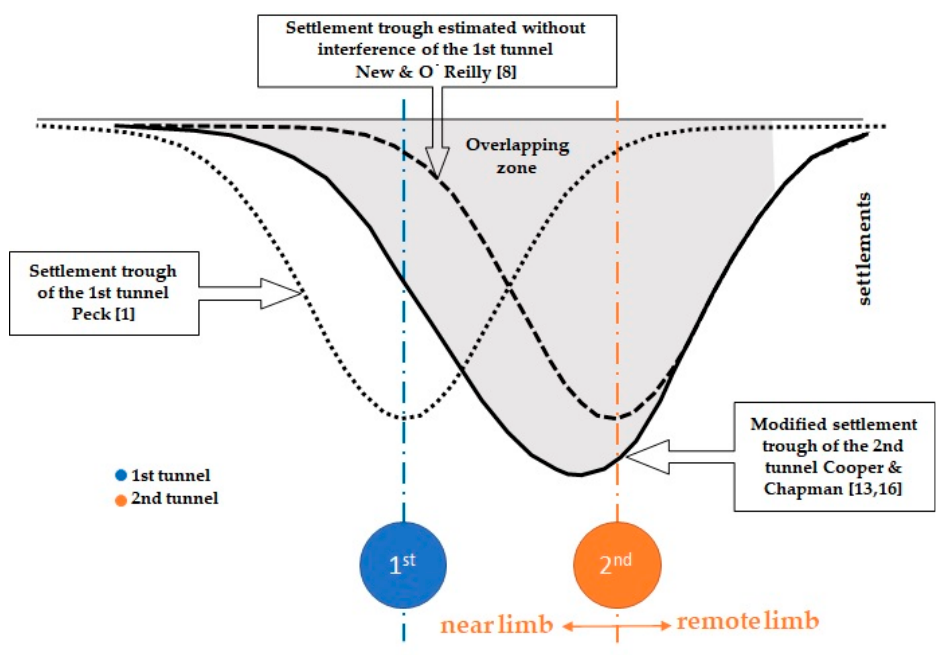
Figure 2. Twin tunnels settlement trough. Cording and Hansmire [11] have suggested that the trough width of side-by-side twin tunnels could increase for the second tunnel on the side near the first tunnel driven. Cooper and Chapman [16] provided a way for estimating the relative increases in the settlement trough width based on an increase in the volume of the near limb, V 2n , relative to the remote limb, V 2r . The volume and hence the half trough width of the near limb were assumed to be greater than that of the remote limb, considering different values of i in the correction factor for each limb of the second tunnel profile, i n (near limb) > i r (remote limb). Incorporating the methodology proposed by Chapman et al. [13], Equations (4) and (5) could be written as Equations (6)–(9).